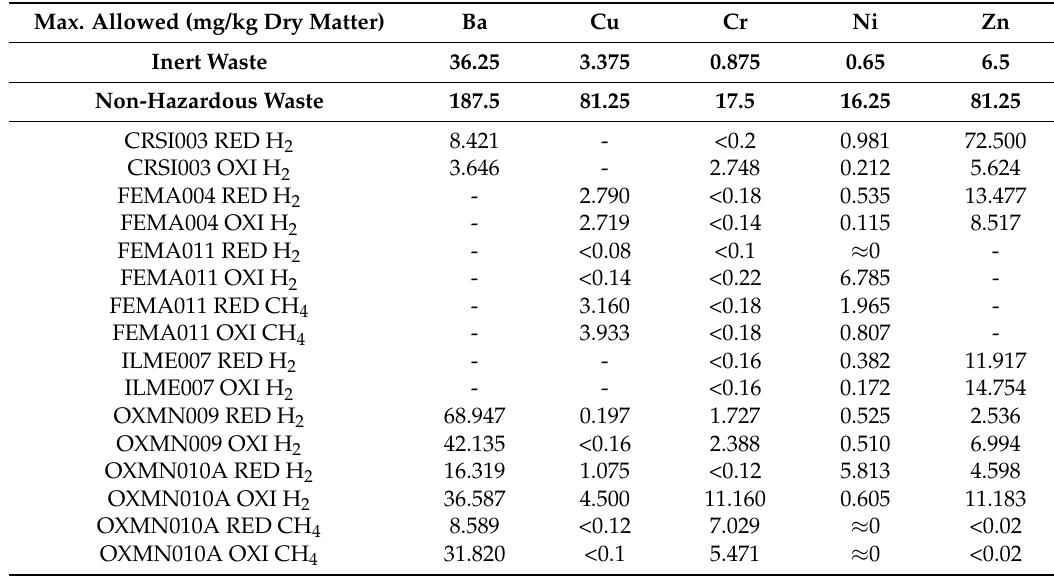
Table 7. Concentration of metals in the leachate of OC residues and maximum values allowed by European regulations (Decision